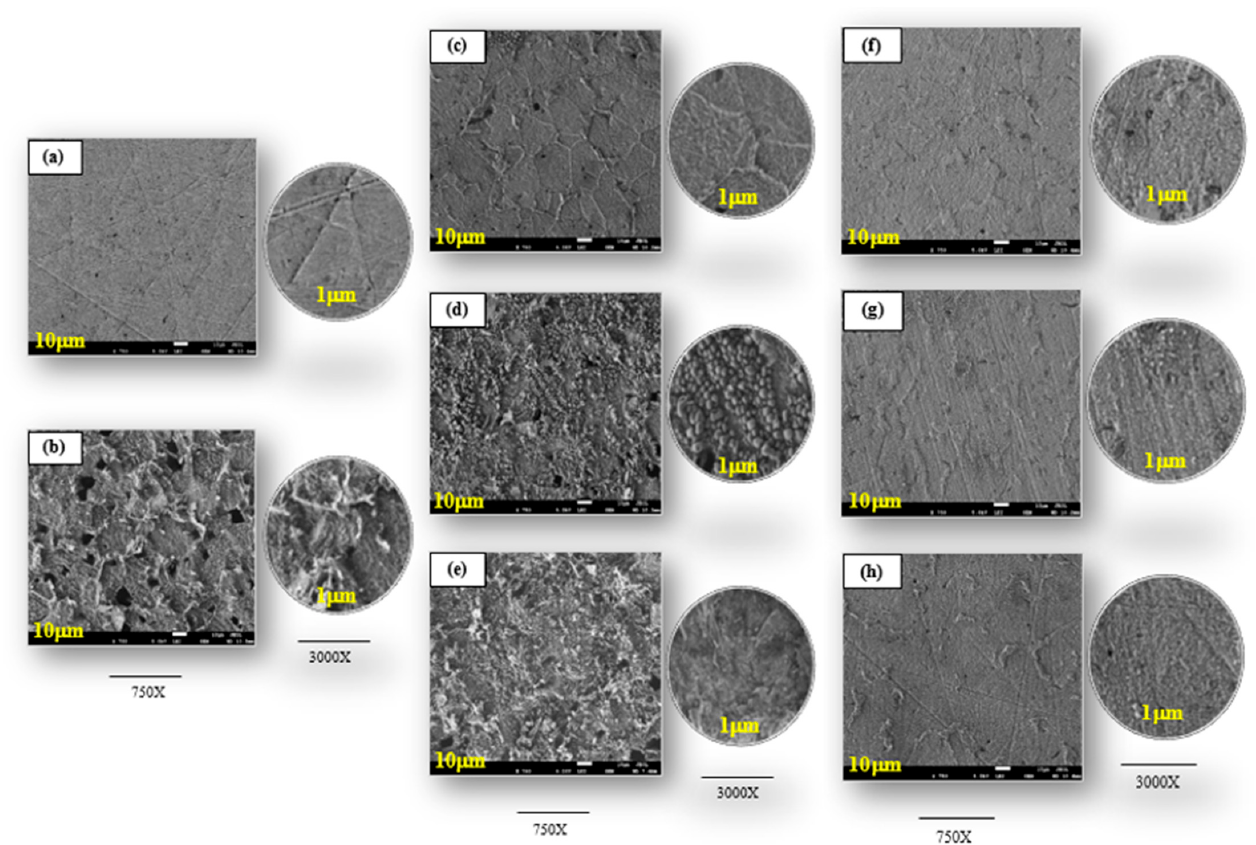
Figure 3. SEM micrographs of mild steel ( a ) only surface abrasion, ( b ) after immersion in 2 M H 3 PO 4 without inhibitors, with 0.025 g L − 1 of ( c ) FEAE, ( d ) ZZAE, ( e ) ITAE, and with 2.5 g L − 1 of ( f ) FEAE, ( g ) ZZAE, and ( h ) ITAE.